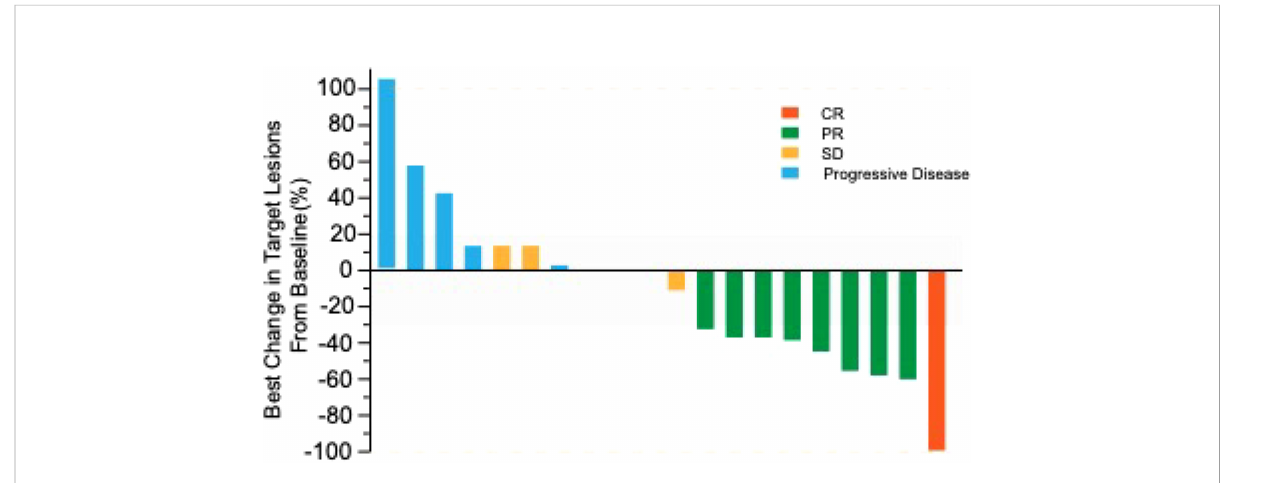
FIGURE 2 Best percentage change from baseline in target-lesion